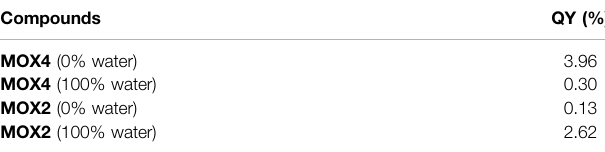
Frontiers in Chemistry |